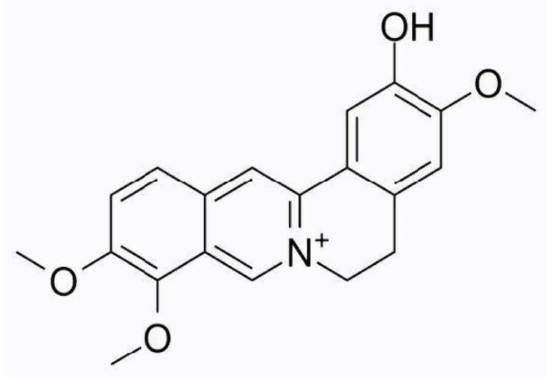
Figure 8. Chemical structure of